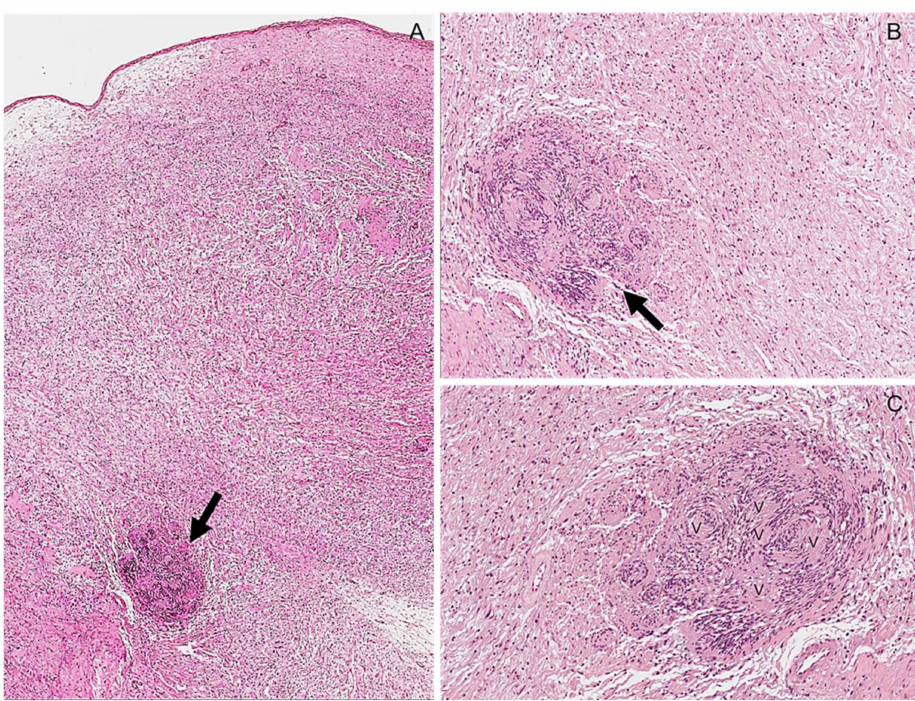
Figure 20. Hybrid neurofibroma/schwannoma tumor. ( A ) Low-magnification image showing a hypocel- lular tumor that predominantly exhibits a conventional neurofibroma morphology, along with small nodules reminiscent of schwannoma (arrow). ( B ) Higher magnification image better showing the nodule of schwannoma (arrow). ( C ) Verocay bodies (v) are seen within the schwannoma